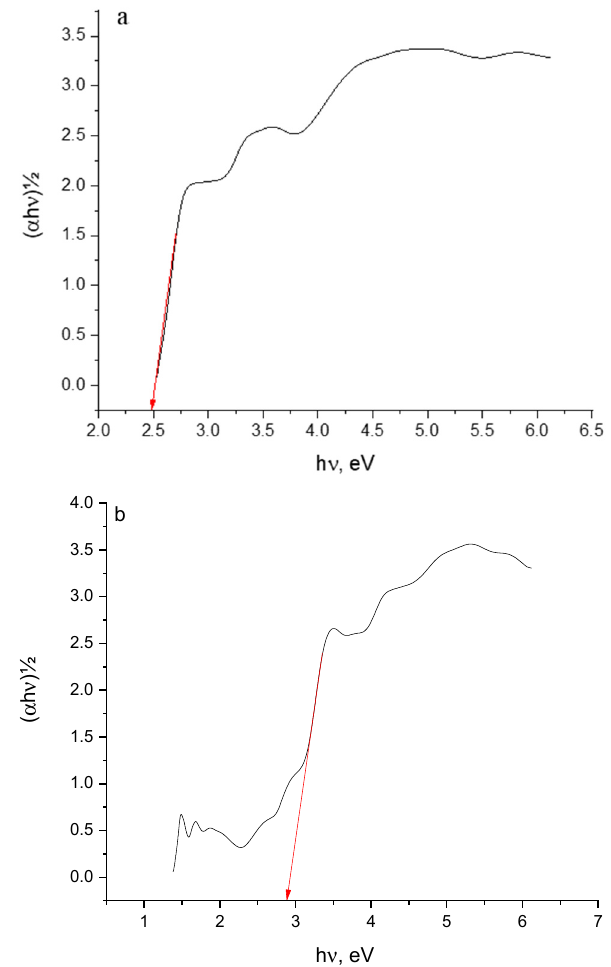
Figure 3. Plots of optical energy (h ν ) against ( α h ν ) ½ for ( a ) haloperidol–picric acid (HPL-PA) and ( b ) HPL-7,7,8,8-tetracyanoquinodimethane CT complexes.